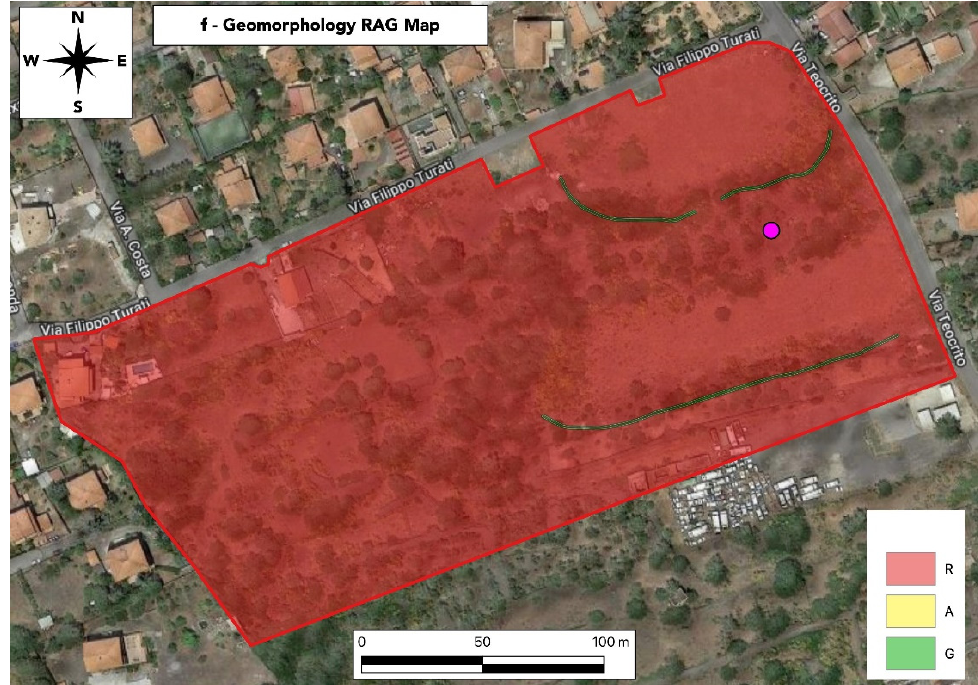
Figure 17. RAG map of the “Geomorphology” layer of the GIS platform. The burial site (pink circle) fell on the Red coded area. For the percentages of RAG color-coded areas see Figure 11 (the Amber-coded area is not visible covering the 1% (0.56) along the Red and Green area boundary).